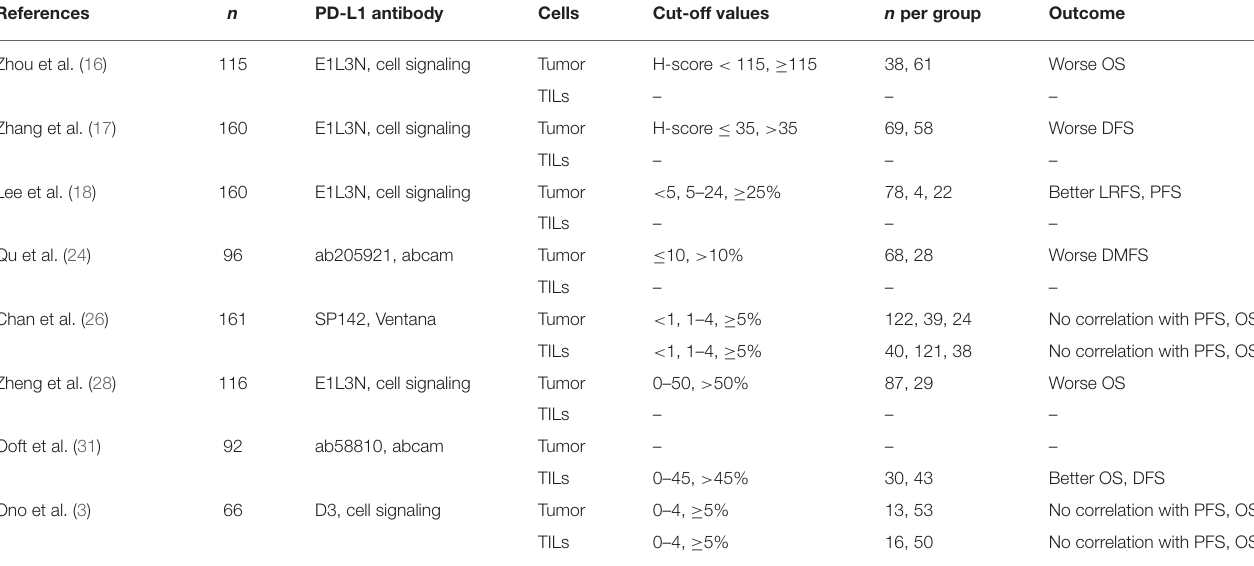
TABLE 4 | Studies investigating the association of outcome parameters and PD-L1 expression in